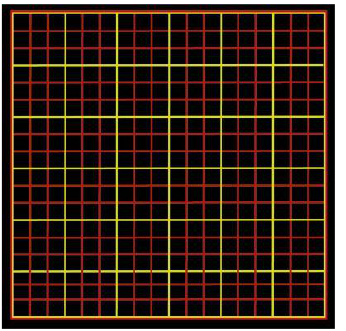
Figure 11. Area of interested divided into target areas